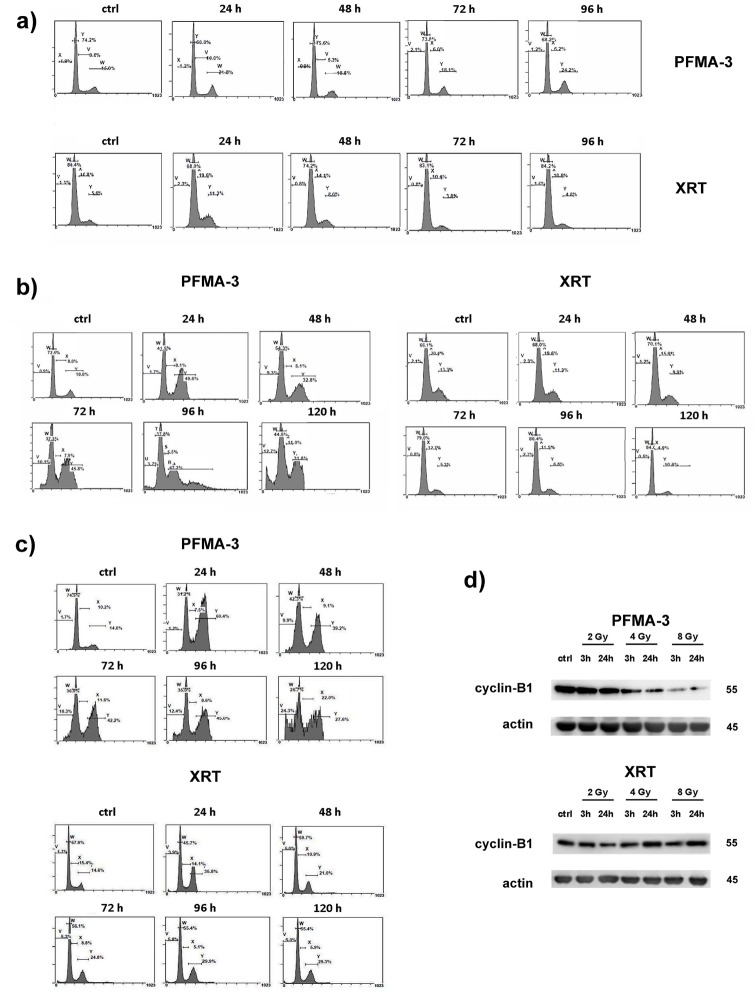
PFMA-3 very high dose rate altered SK-Mel28 cell cycle distribution more severely than XRT and finally induced the appearance of sub-G1 peak.Flow cytometric analysis of cell cycle distribution in SK-Mel28 cell line treated with a) 2 Gy b) 4 Gy c) 8 Gy PFMA-3 and XRT for different times. The histograms were representative of three separate experiments. ctrl, control cells. d) Western blot analysis documenting cyclin-B1 levels modulation in PFMA-3 and XRT irradiated cells. Antibody to b-actin served as a loading control. ctrl, control cells.